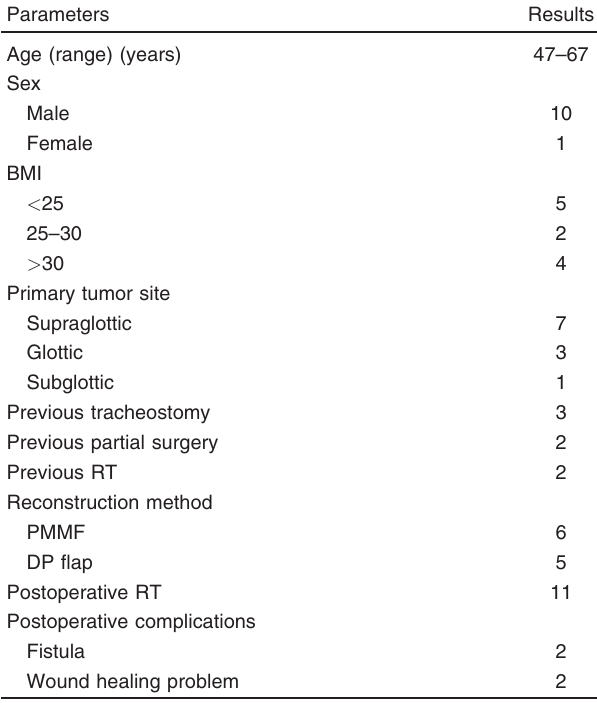
Table 1 Summary of the results of the study Parameters